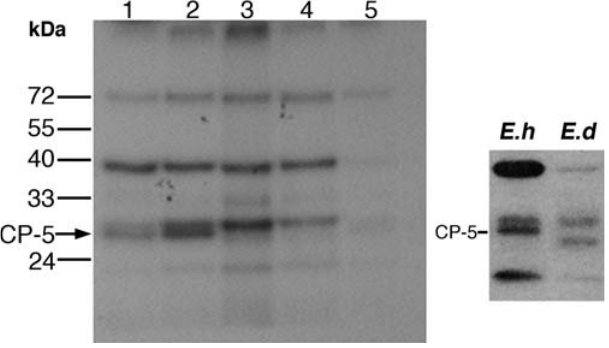
Figure 6. In Vivo Labeling of Cysteine Proteinases The different trophozoite cultures were grown for 18 h with the radiolabeled cysteine proteinase inhibitor Fmoc-[I 125 ]Tyr-Ala-diazome- thylketone (10 l g/ml, 10 l Ci/ml), harvested, washed, and lysed [49]. Samples of each cell lysate (25 l g) were separated on a 12% acrylamide reducing gel and exposed to X-ray film to reveal the different cysteine proteinase bands. Samples in the lanes on the left radiograph are: 1, untransfected HM-1:IMSS; 2, untransfected G3; 3, G3 transfected with pAP-CP5 and grown with 50 l g/ml of G418; 4, RB8 trophozoites after removal of the plasmid (see Results); 5, HM-1:IMSS grown with a lower specific activity inhibitor (0.05 l Ci/ l g). Samples on the right radiograph demonstrate the CP-5 band location in HM-1:IMSS and its absence from the E. dispar culture [50].